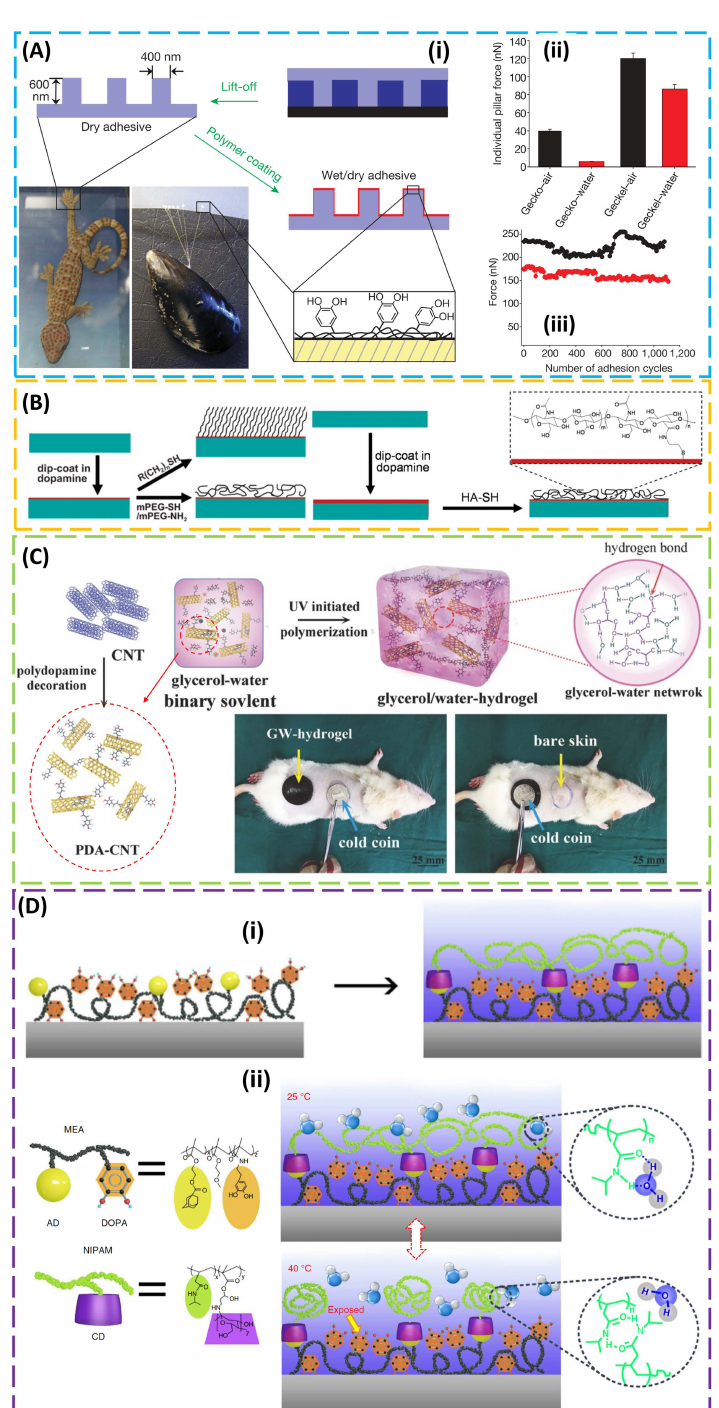
Figure 3. Mussel-inspired wet adhesives. ( A ) ( i ) PDMS casting onto the master is followed by curing, and lift-off results in gecko-foot-mimetic nano-pillar arrays. Next, the fabricated nanopillars are coated with a mussel-adhesive-protein-mimetic polymer that contains catechols, a key component of wet adhesive proteins found in mussel holdfasts. ( ii ) Adhesion force per pillar for gecko and geckel in water